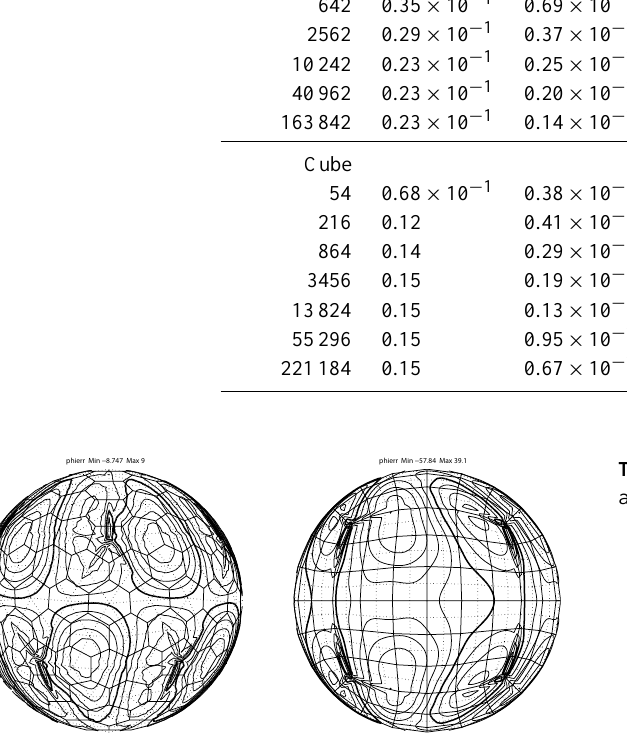
Figure 5. Geopotential error (m 2 s − 2 ) after 5 days for the solid body rotation test case. Left: a hexagonal–icosahedral grid with 10242 cells. Right: a cubed-sphere grid with 13824 cells. In each case 11 evenly spaced contours (i.e. 10 intervals) are used between the minimum and maximum values.